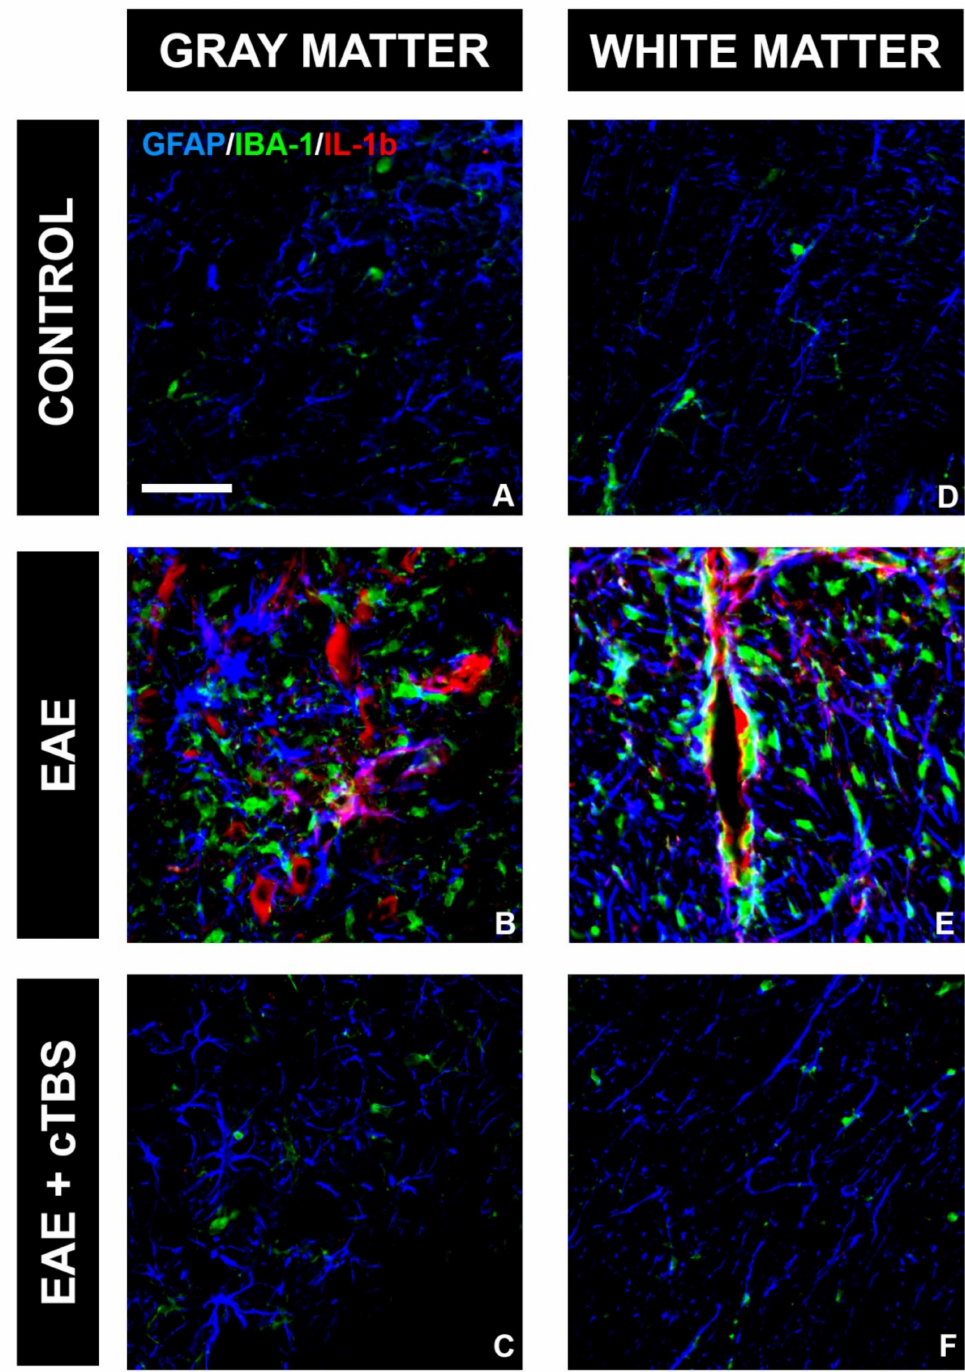
Figure 3. Effect of CTBS treatment on IL-1 β expression in gray and white matter of EAE rats. Triple immunofluorescence labeling directed to astrocyte marker GFAP (blue), microglial marker IBA-1 (green), and pro-inflammatory cytokine IL-1 β (red). Expression of IL-1 β was not detected in control sections ( A , D ). In EAE sections, increased IL-1 β immunostaining in gray ( B ) and white matter ( E ), colocalizing with both GFAP and IBA-1 cells. After CTBS treatment, no IL-1 β - ir was observed ( C , F ). Scale bar corresponds to 50 µ